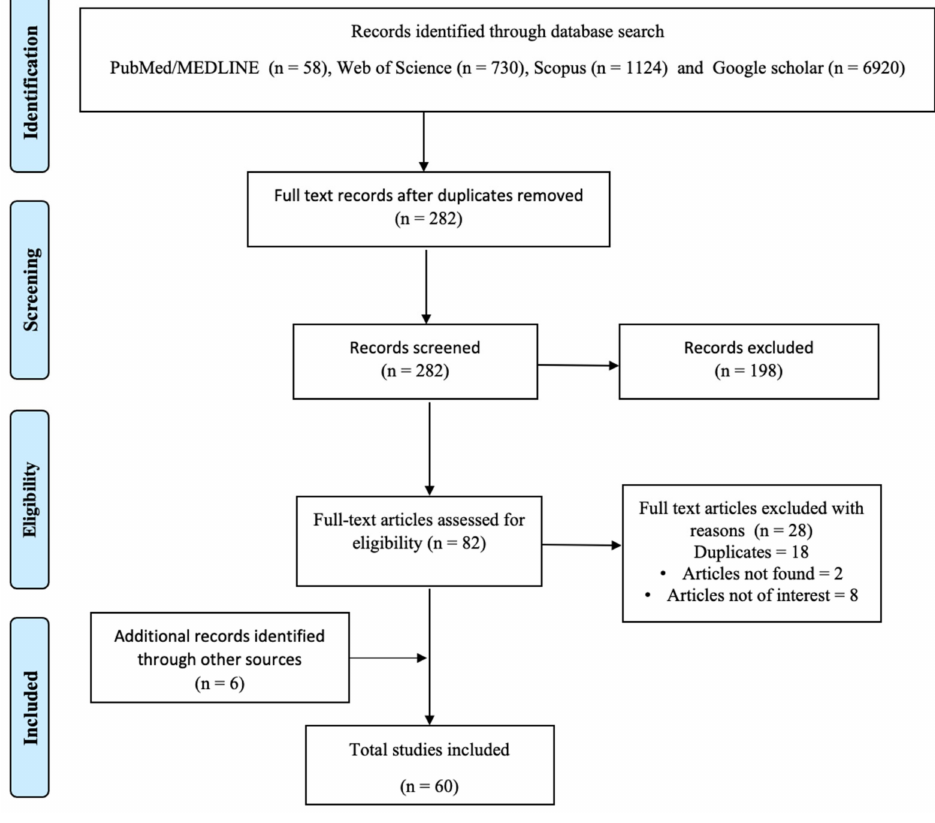
Figure 1. PRISMA flow diagram for the scoping review